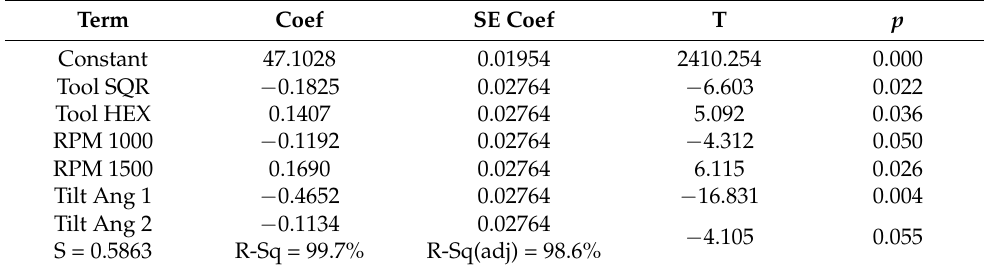
Table 6. Estimated model coefficients for SN ratios.